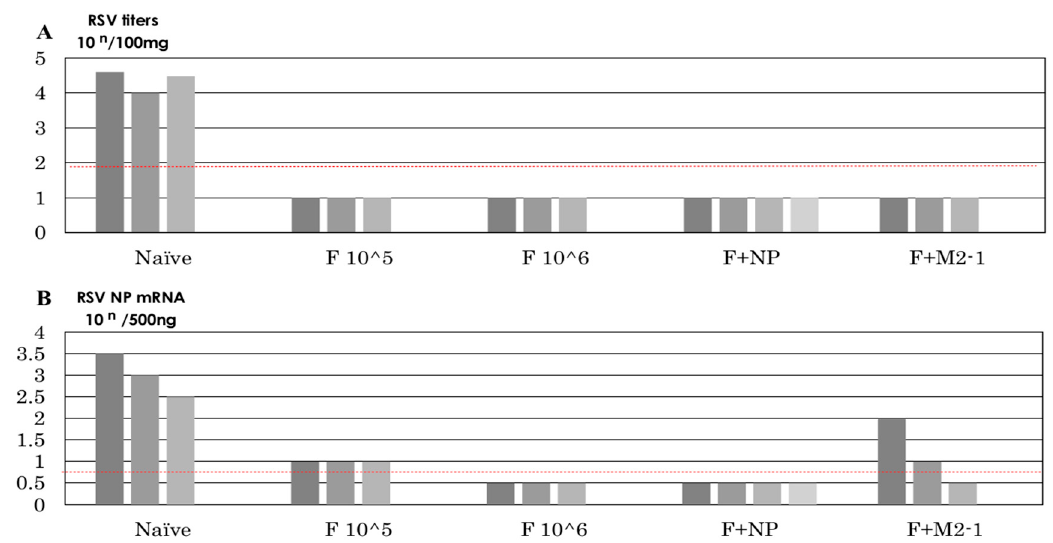
Figure 7. Recovery of infectious RSV and genome copy numbers after the RSV challenge. ( A ) Lung tissues were homogenized and diluted. Lung homogenates were placed on HEp-2 cells and incubated for six days. Plaque numbers were counted. Infectivity is shown as PFU in 100 mg of lung tissue. ( B ) The copy number of the RSV-NP gene is shown. TaqMan PCR was performed in the RSV-NP gene region. Dotted red lines indicate the detection limits.